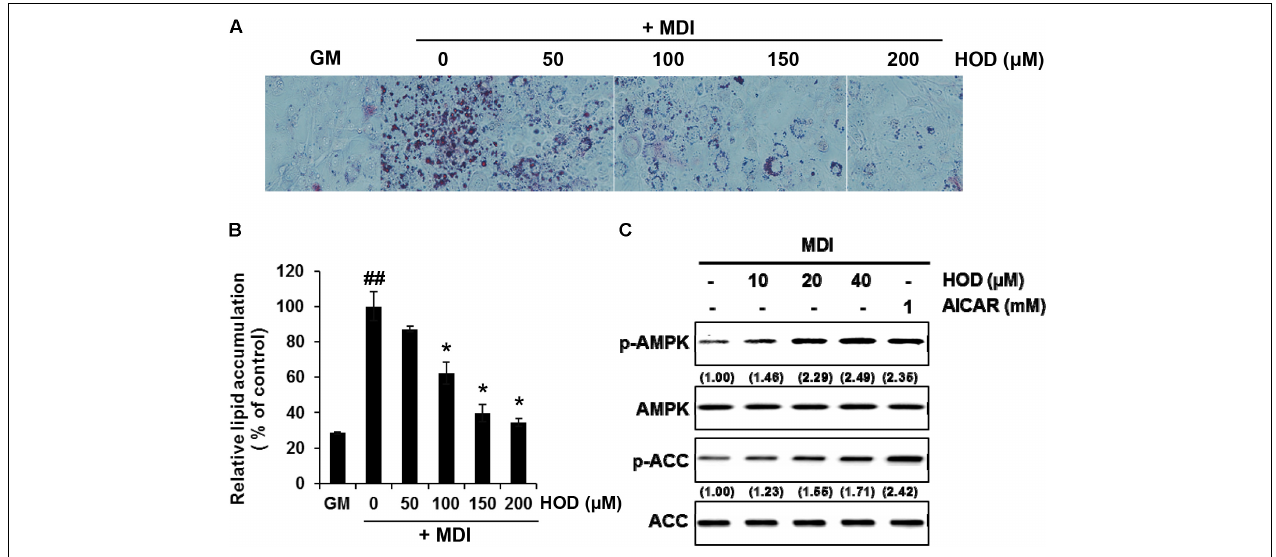
FIGURE 5 | Effect of HOD on early adipogenesis of 3T3-L1 and phosphorylation of AMPK and ACC. 3T3-L1 preadipocytes were differentiated into adipocytes in the presence of specified concentrations of HOD. (A) After 7 days, intracellular lipid droplets were stained using Oil-red O, and observed microscopically. (B) Quantification of intracellular lipid accumulation. Total lipids stained with Oil red-O were extracted in absolute isopropanol, after which the absorbance of the solution was measured at 500 nm. The bar graphs show the mean ± S.D. of 3 independent experiments ( ## p < 0.01 compared with the GM control; ∗ p < 0.05 compared with the MDI-treated alone control). (C) Total protein and their phosphorylated form levels of AMPK and ACC were analyzed by western blotting. The numbers at the bottom of the figure indicate the relative band intensity normalized to that of the non-phosphorylated protein (fold-change in comparison with that of the control